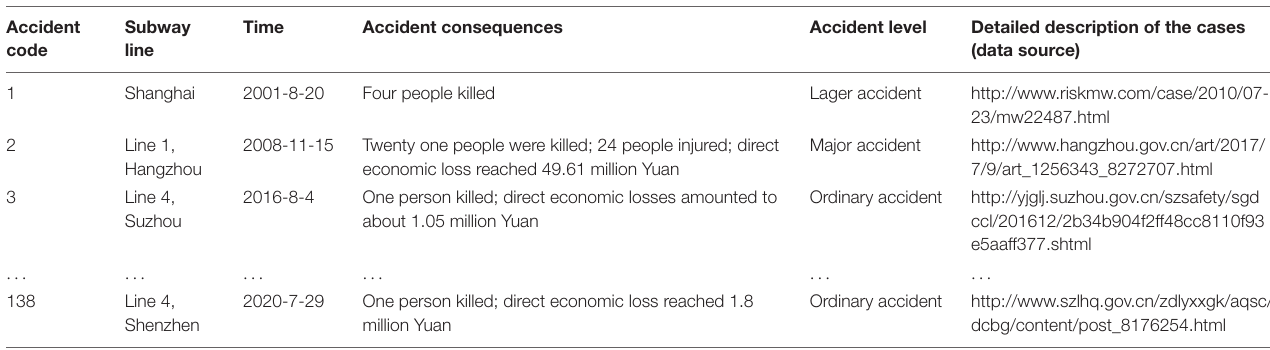
FIGURE 1 | Accident causation model diagram. TABLE 1 | Statistics of accident